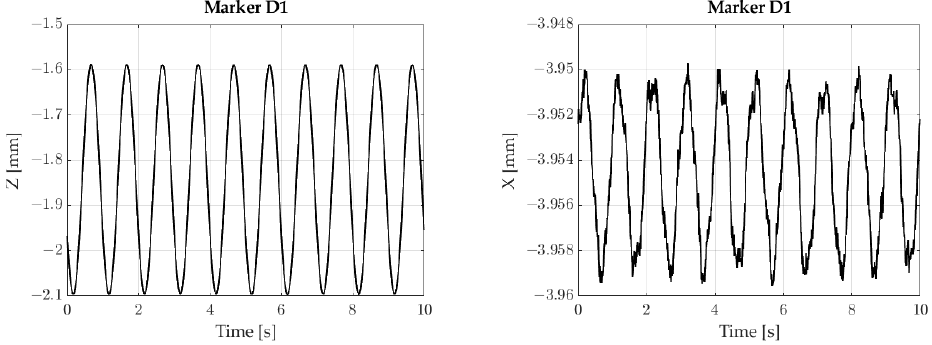
Figure 16. Recorded signals.